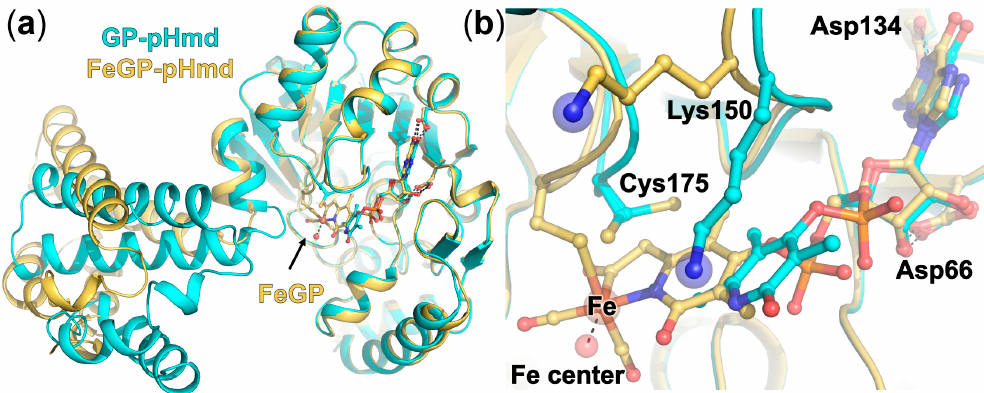
Figure 5. Structural comparison of the GP-bound form (cyan) of pHmd and the FeGP-bound form (yellow) of the pHmd asymmetric homodimer. ( a ) Monomers of each structure are shown by a cartoon model. The N-terminal domains were superposed. ( b ) Zoomed-in view of the active site. GP and FeGP are shown by ball and stick models. In the GP-bound form, the carboxymethyl group of GP is not visible. Hydrogen bonds are indicated by dashed lines.